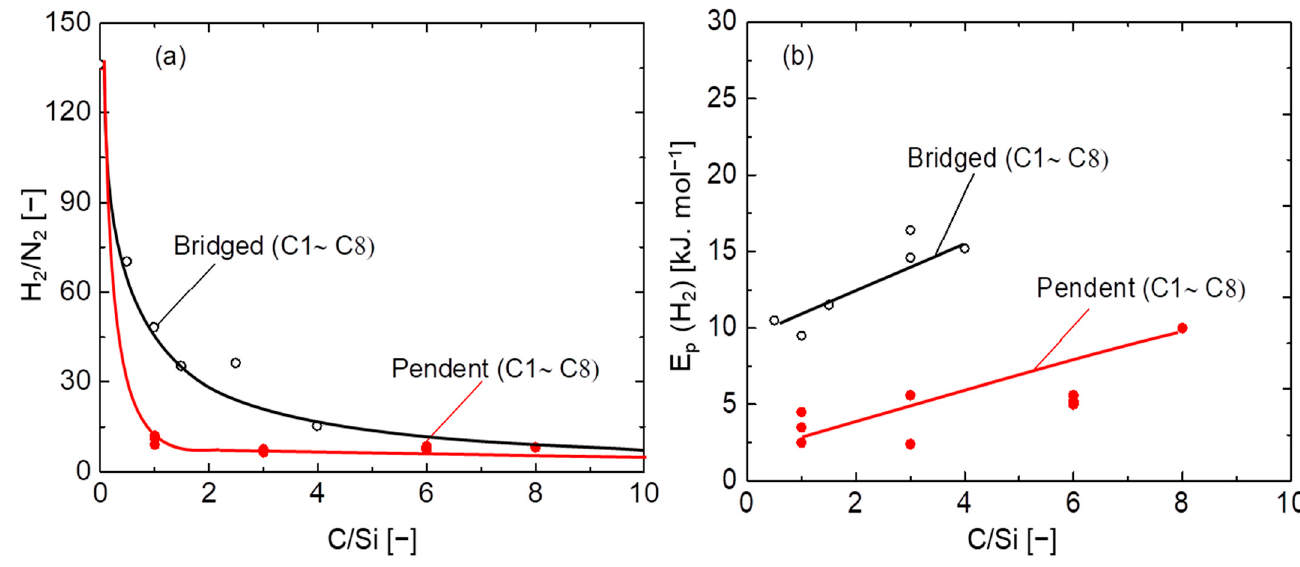
Figure 4. Relationship between C/Si ratios, H 2 /N 2 selectivity at 200 °C ( a ), and activation energy ( b ) for pendant– and bridged–type organosilica membranes calcined at 300–350 °C under a N 2 at- mosphere.